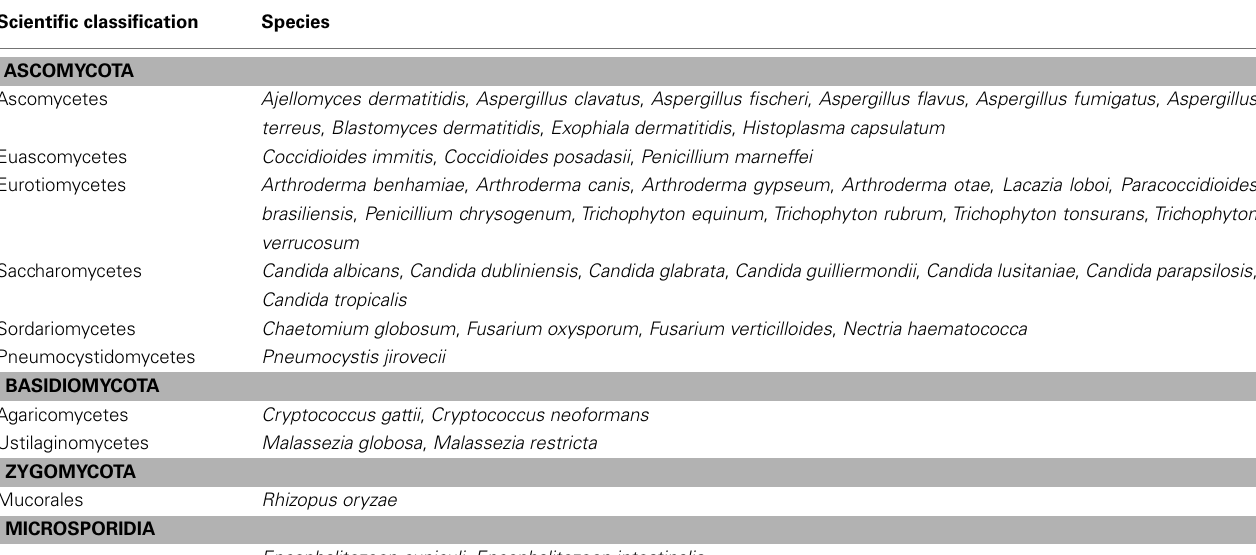
Table 2 | List of human-pathogenic fungi of which the genomes have been sequenced. Scientific